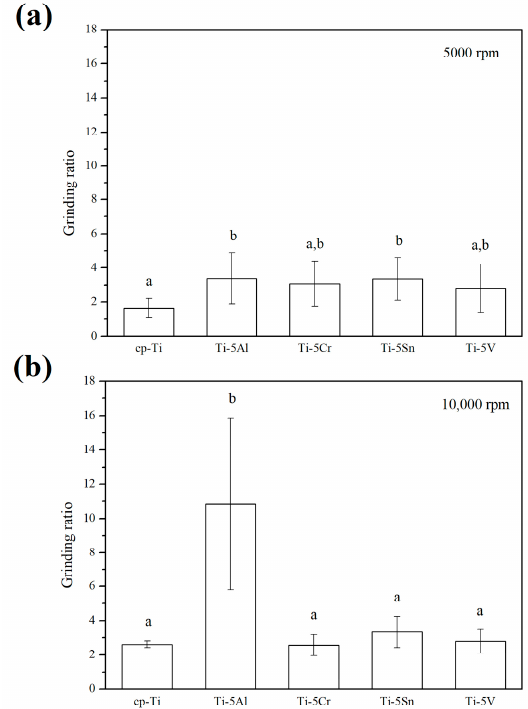
Figure 5. The grinding ratios of cp-Ti and Ti alloys ground using an SiC wheel at revolution speeds of 5000 rpm and 10,000 rpm ( n = 7). The superscript alphabets ( a , b ) indicate significant differences at the p = 0.05 level according to Duncan’s multiple range tests. The mean values with the same superscript alphabet are not statistically different ( p > 0.05).